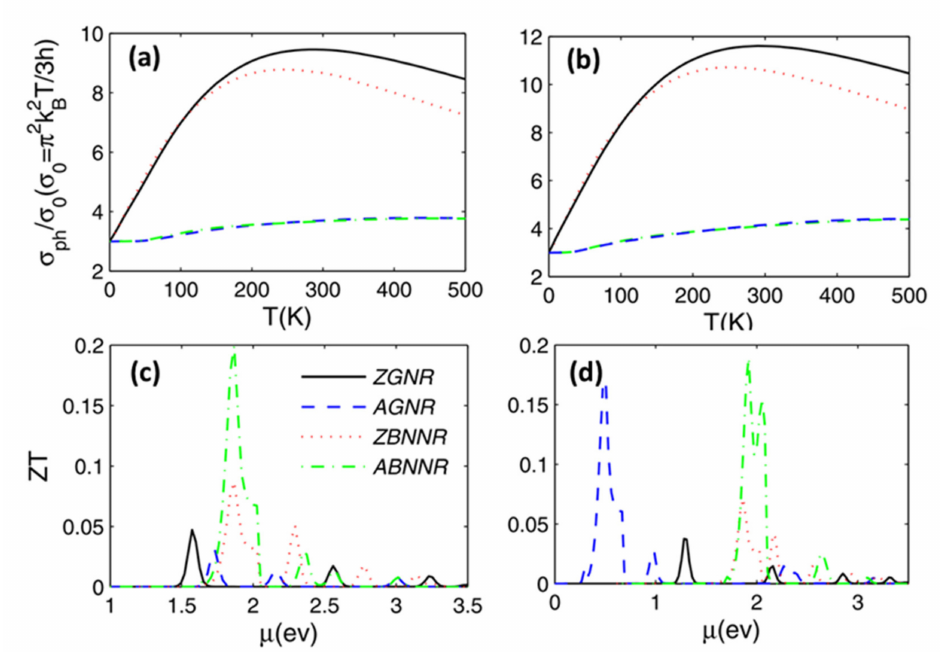
Figure 7. ( a , b ) Phonon thermal conductance K ph /K 0 as a function of the temperature T. ( c , d ) figure of merit ZT as a function of the chemical potential µ . [128] In the left columns ( a , c ), N A (N Z ) = 8, while in the right columns ( b , d ), N A (N Z )= 10. (Reprinted with permission from AIP Publishing, Copyright ©